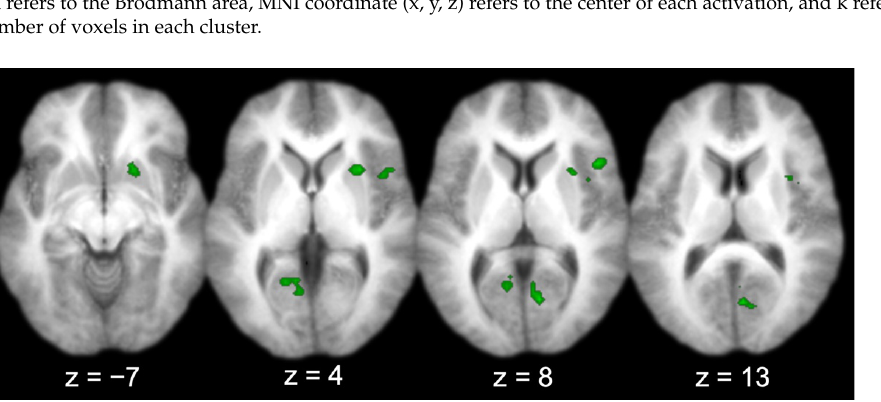
Figure 4. Entorhinal cortex functional connectivity group results (for all participants; axial slices). Males produced greater connectivity between the entorhinal cortex and the right IFG/insula (0.29 ± 0.07, F(1,20) = 8.86, p = 0.010, Bonferroni-corrected p < 0.05) and the